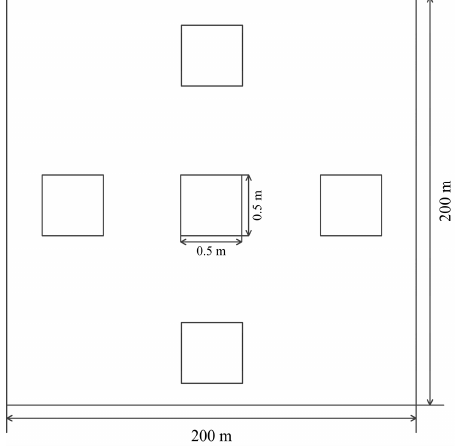
Figure 3. Location of sample quadrats in a sample plot.